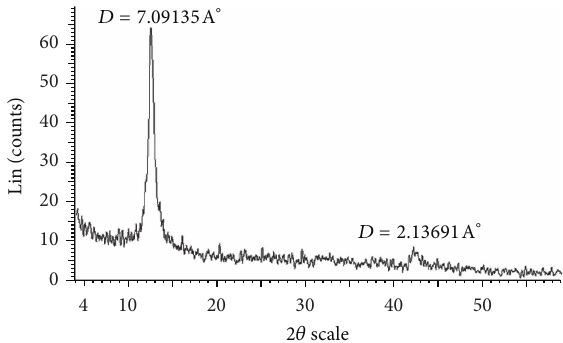
Figure 3: X-ray diffraction patterns of the synthesized nanogra- phene oxide.